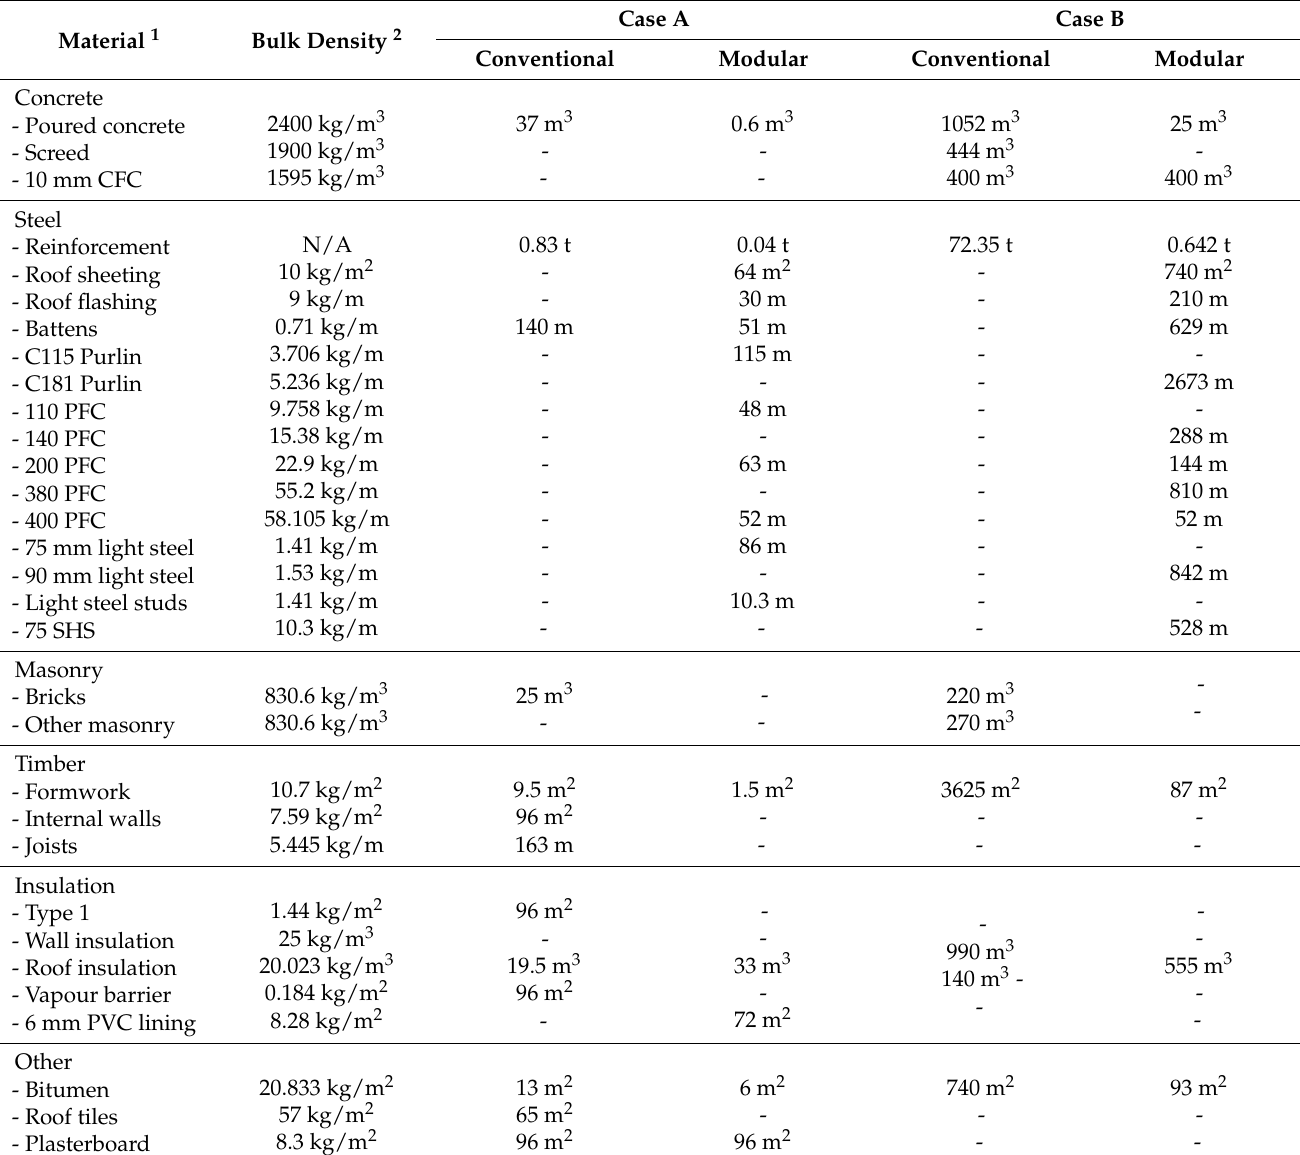
Table 4. Summed material quantity take-offs and bulk densities for case studies and construction methods. Material